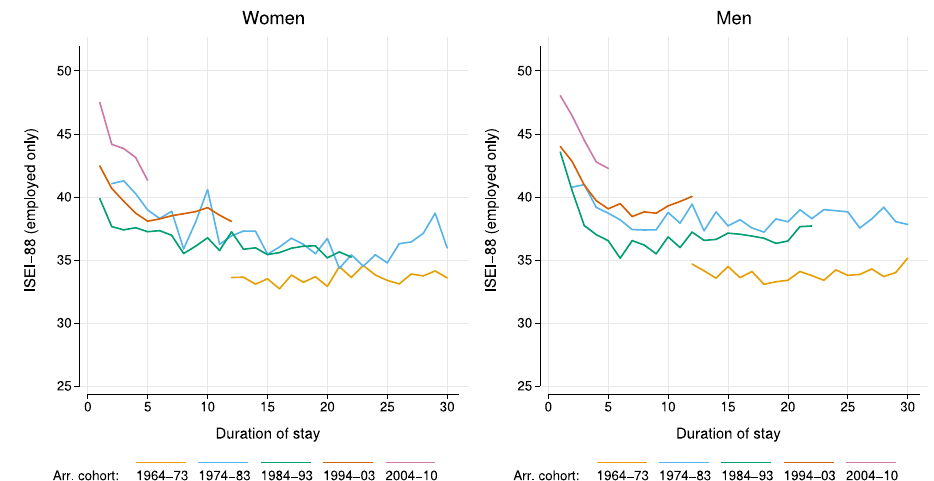
Figure 5 : Occupational status by duration of stay and arrival